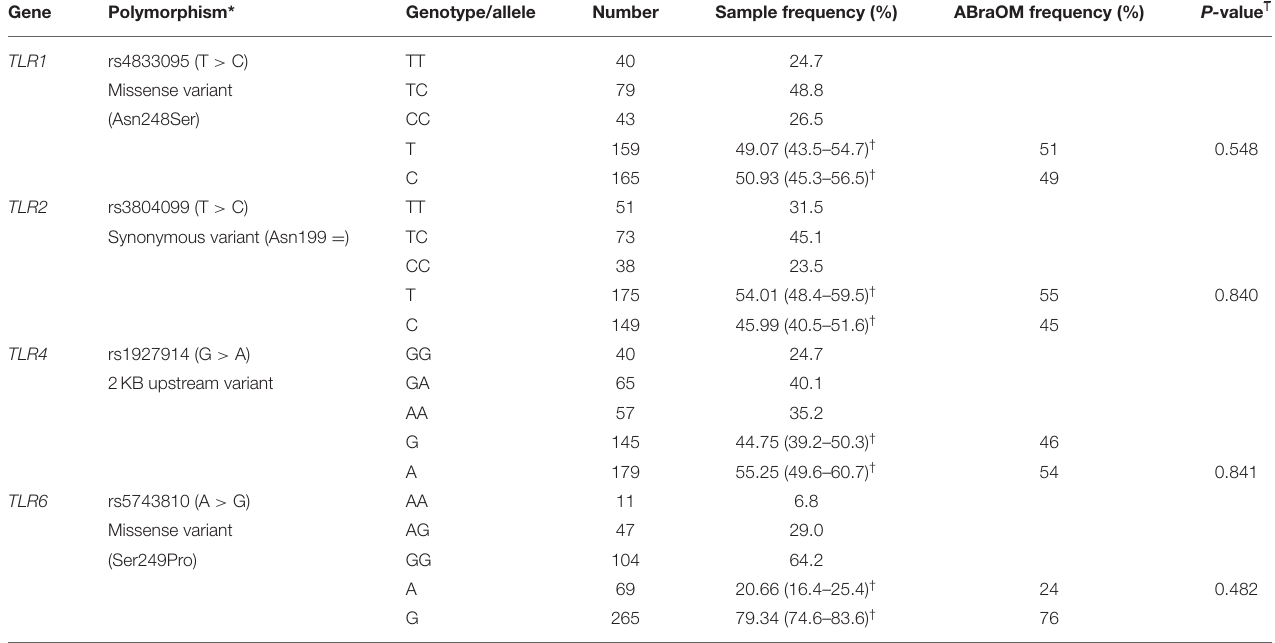
TABLE 2 | Genotype and allele frequency of toll-like